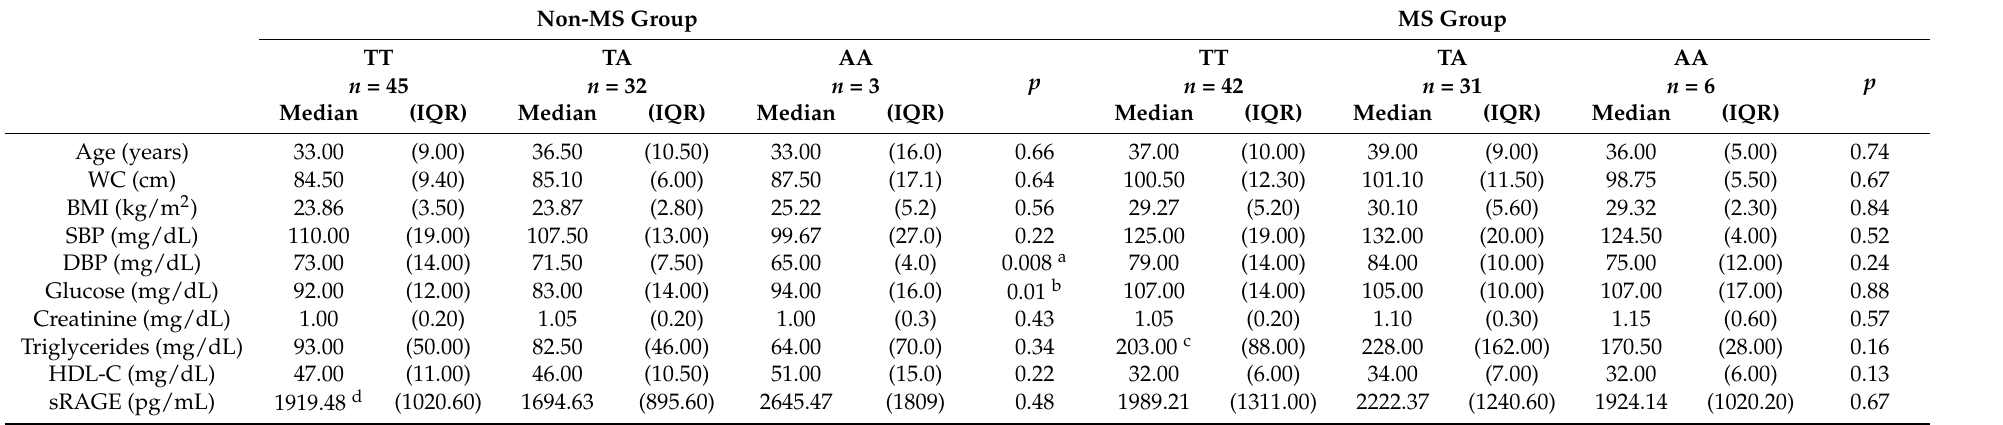
Table 3. Clinical and metabolic variables according to genotypes of the − 374 T/A